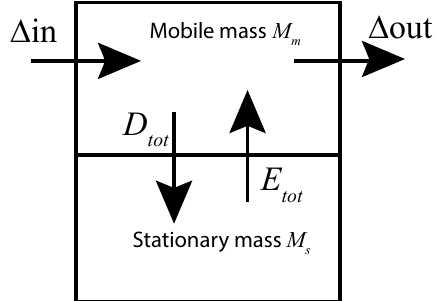
Figure 5. Sediment dynamics at the bed are modelled by two reser- voirs for stationary and mobile mass, which can exchange material by entrainment ( E tot ) and deposition ( D tot ). Sediment mass can be supplied from upstream ( (cid:49) in) and can leave in the downstream di- rection ( (cid:49)